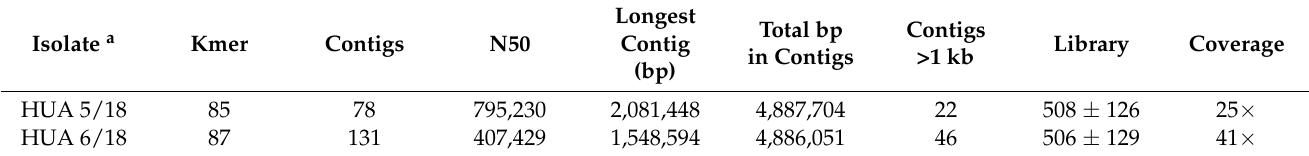
Table 1. Parameters related to the quality of the assemblies of the genomes of two clinical isolates of Salmonella enterica serovar Corvallis resistant to